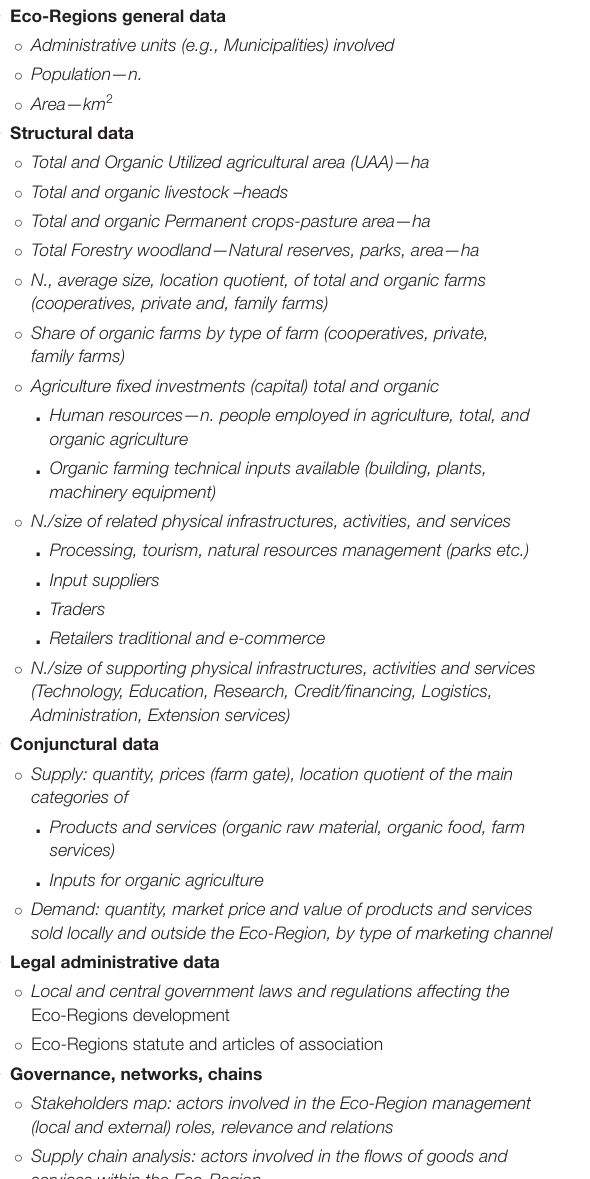
TABLE 2 | Eco-Regions Context analysis suggested